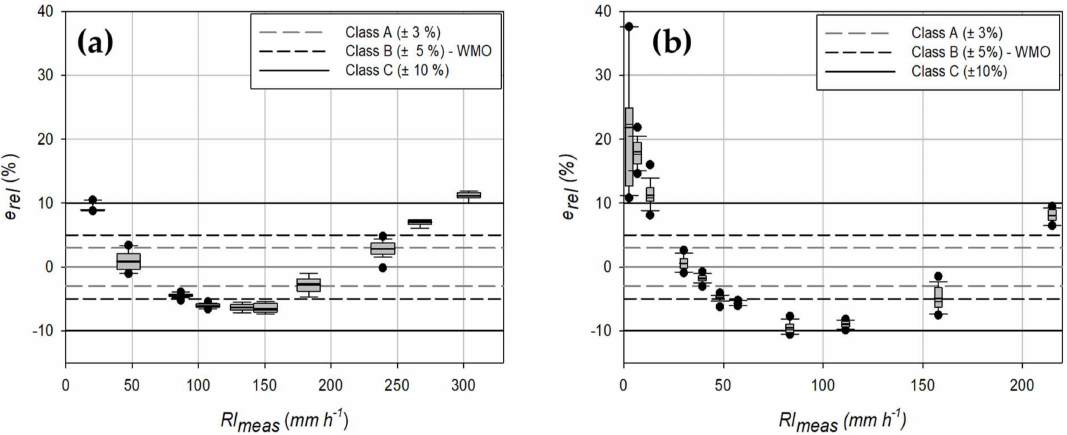
Figure 3. Dynamic calibration results for ( a ) the OSC and ( b ) the CRAL gauges, assuming a constant volume for the generated drops. Horizontal lines indicate the limit of the European standard classification and the WMO